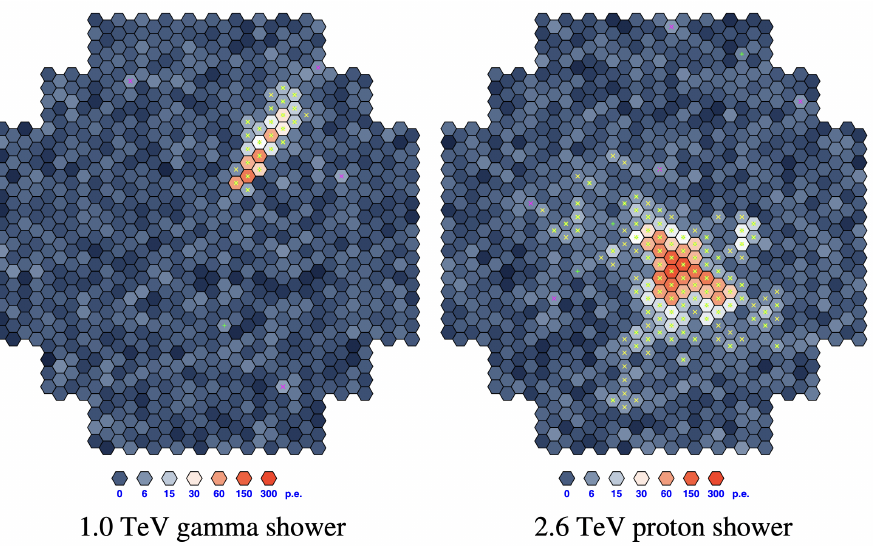
Figure 2. Difference between the images of gamma-induced ( left ) and hadron-induced ( right ) showers in the camera of a IACT. Reprinted with permission from Ref. [12]. Copyright 2009 Völk et